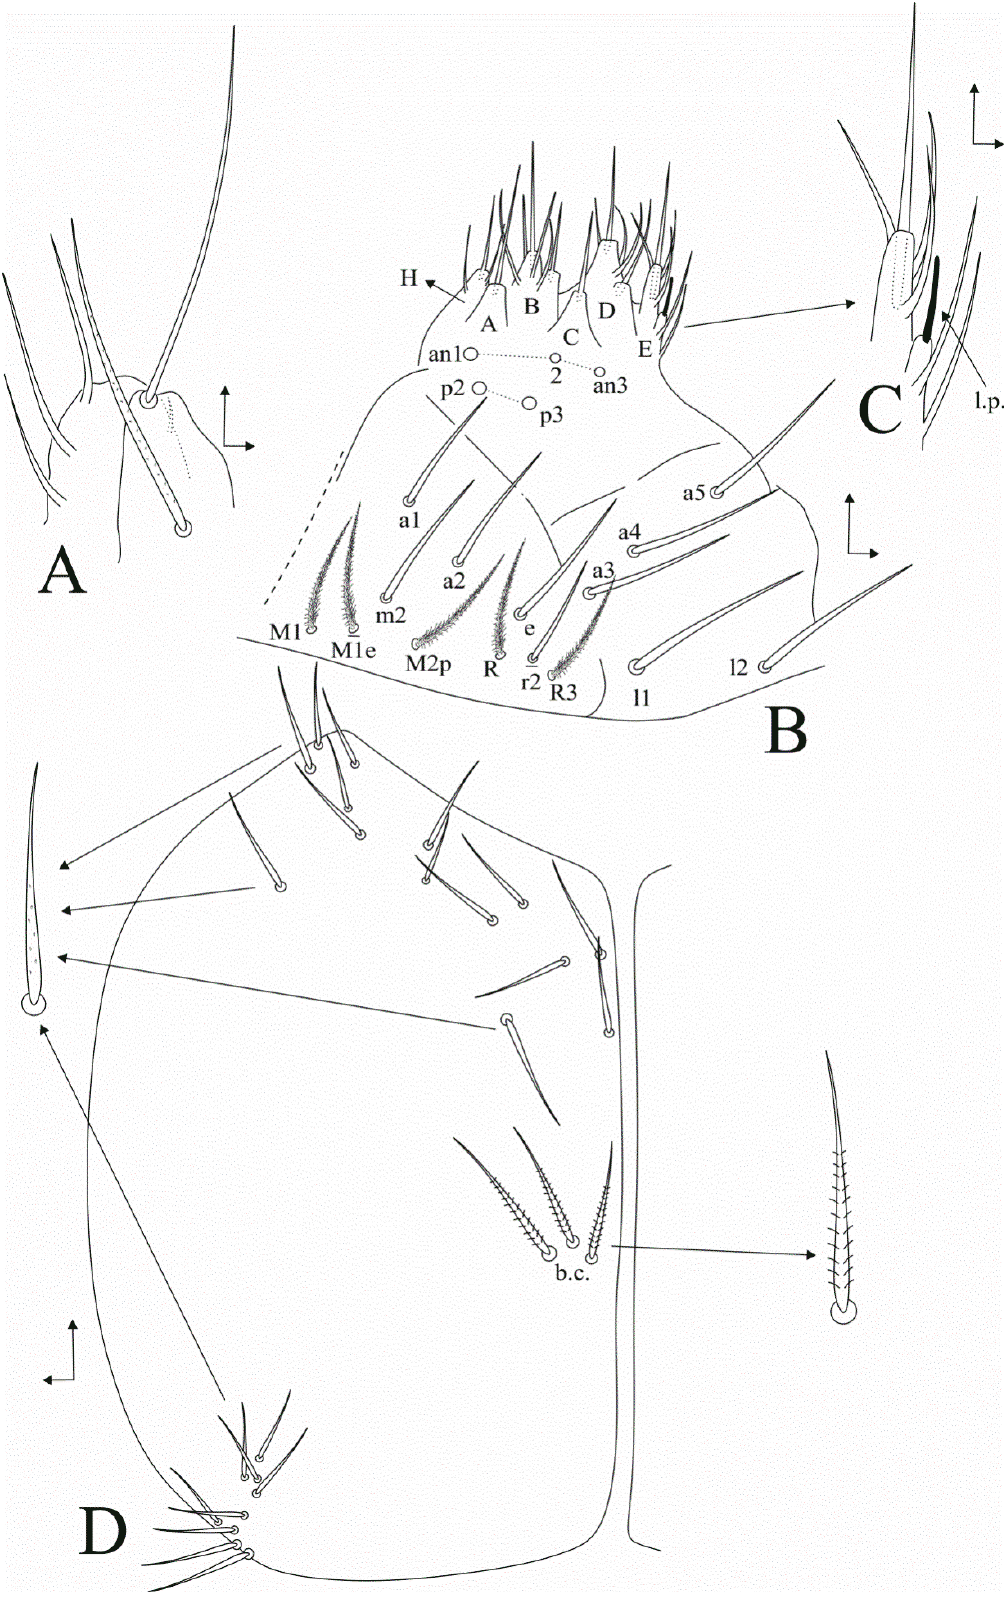
Figure 3. Dicranocentrus abestado sp. nov. ventral head: ( A ) maxillary outer lobe and sublobal plate (right side); ( B ) labium (right side); ( C ) labial papilla E (right side), arrow indicates lateral process ( l.p. ); ( D ) post-labial chaetotaxy (left side), arrows indicate morphology of chaetae, ( b.c. ) = basal chaetae.